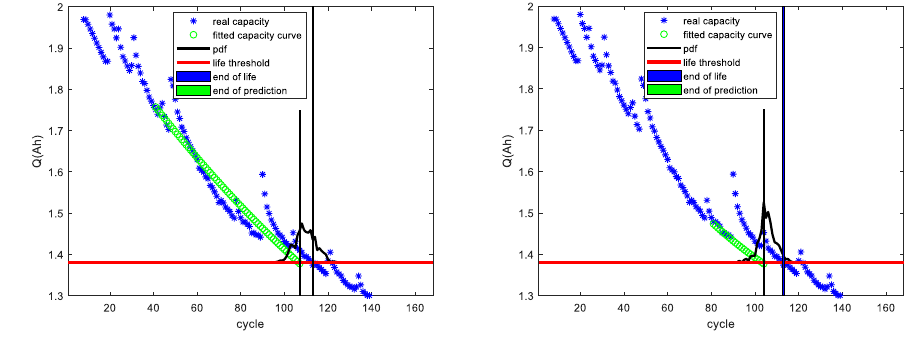
Figure 10. RUL prediction results of the B6 battery using KCCPF. Table 4. RUL prediction results of the B6 battery using